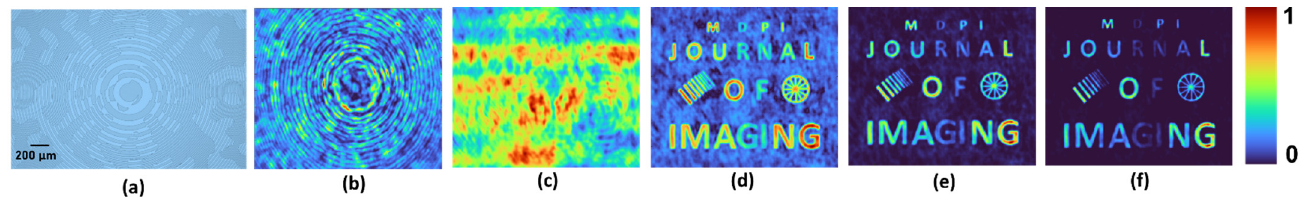
Figure 15. ( a ) Optical microscope image of the randomly multiplexed bifocal diffractive lenses. ( b ) Recorded PSF, ( c ) object’s response pattern. Reconstruction results using ( d ) NLR ( p = 1), ( e ) NLR ( p = 2) and ( f ) NLR ( p = 3) for FINCH with spatial random multiplexing configuration.